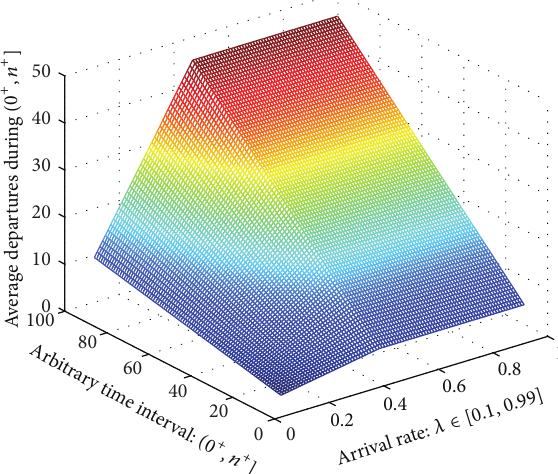
Figure 2: Effect of arrival rate and time interval on expected departure